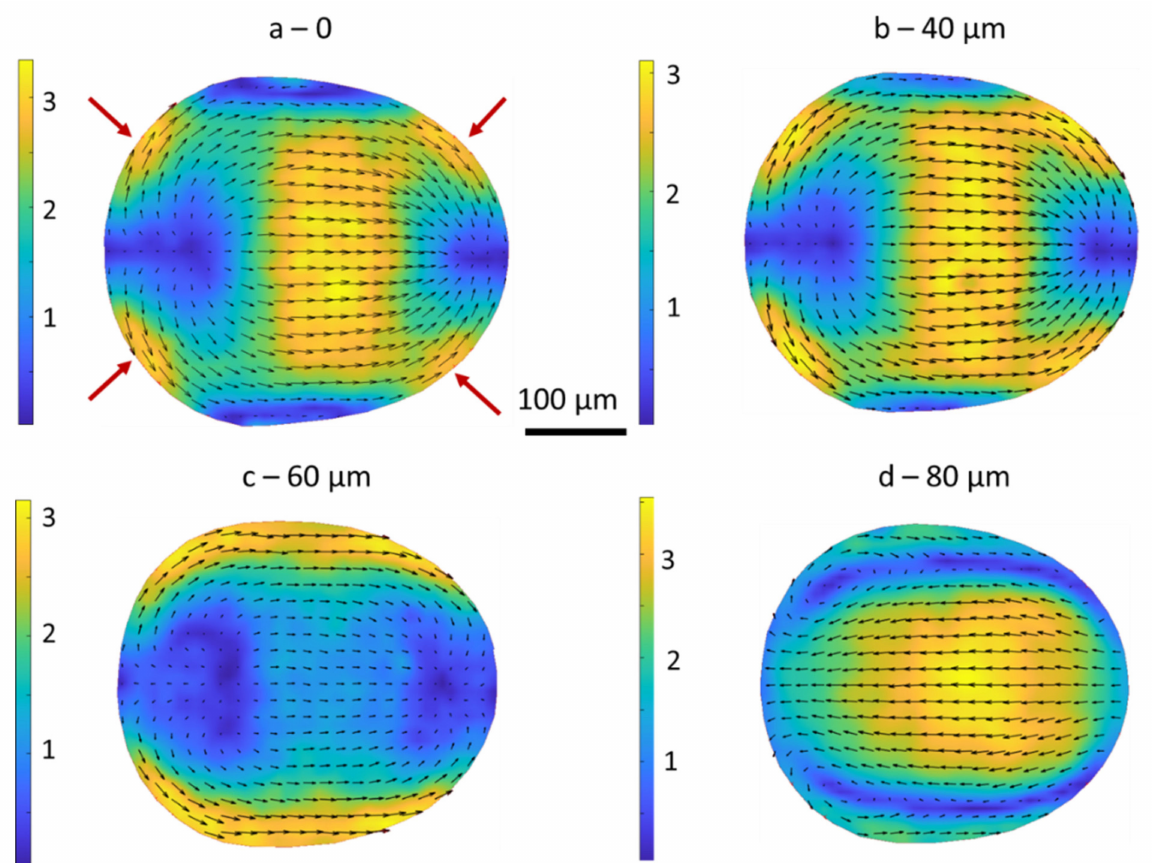
Figure 3. Flow fields inside a surfactant-free drop in the co-ordinate frame moving with the drop: ( a ) drop cross-section corresponding to the middle plane of the channel, ( b ) cross-section at 40 µ m from the middle plane, ( c ) 60 µ m, ( d ) 80 µ m. Drop length L = 396 ± 3 µ m, drop velocity V d = 10.7 ± 0.3 mm/s. Total flow rate Q = 32 µ L/min The velocity on color scales is given in